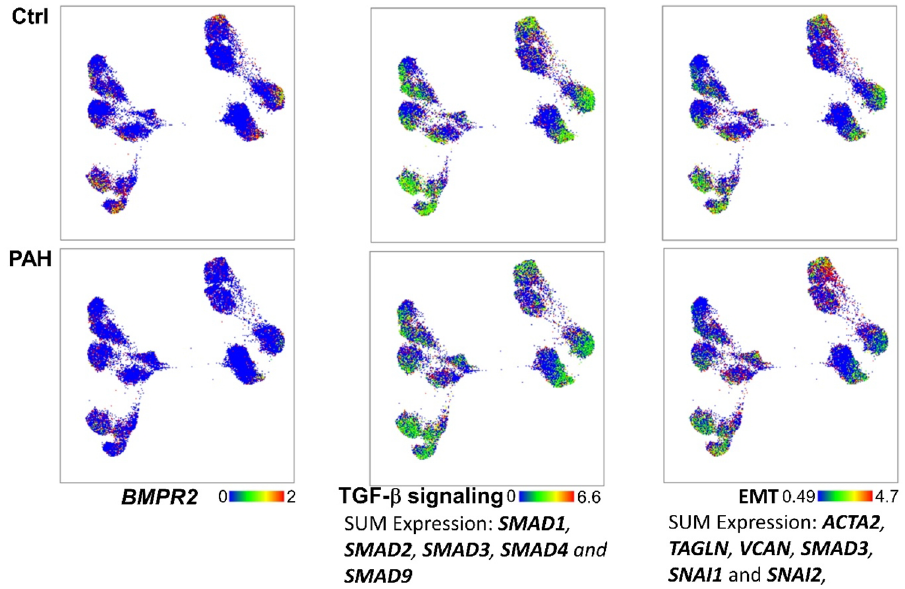
Figure 7. BMPR2, TGF-β signaling genes and Endothelial-to-Mesenchymal Transition markers. BMPR2 and sum expression of genes in TGF-β pathway and Endothelial-to-Mesenchymal Transition (EMT) is shown. Genes in bold were down-regulated in the total PAH PAEC population.